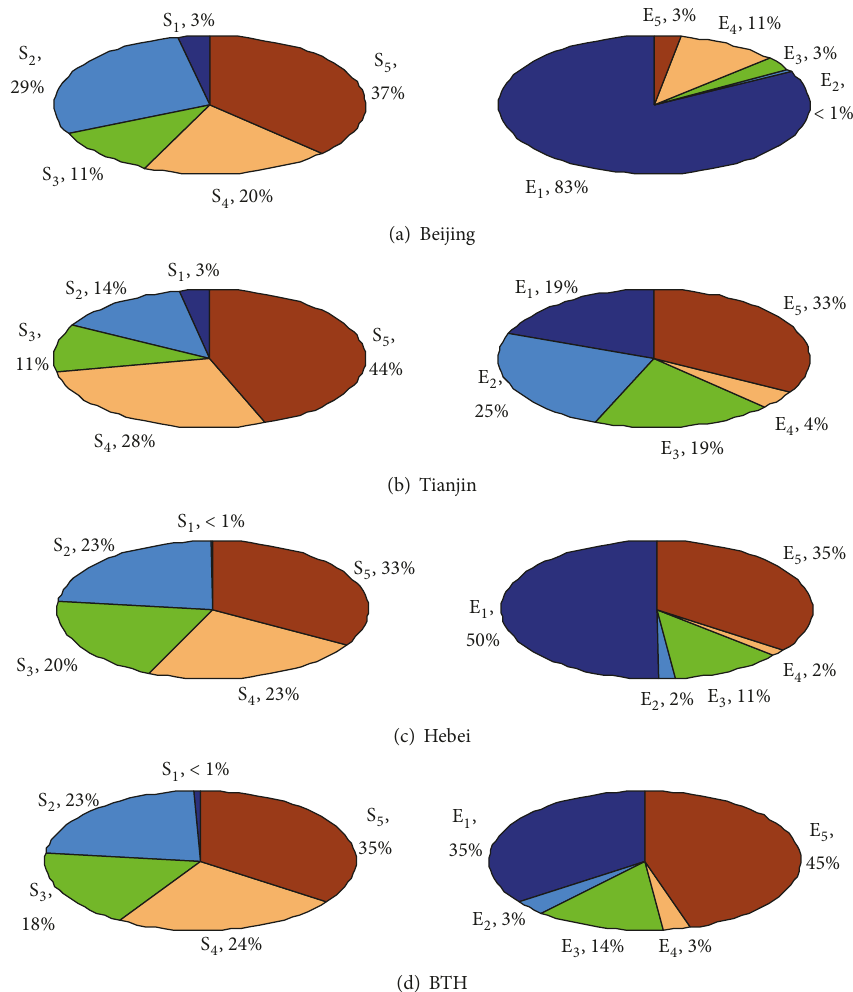
Figure 1: Pie charts of indicator weights for socioeconomic development and environmental pollution in each region.